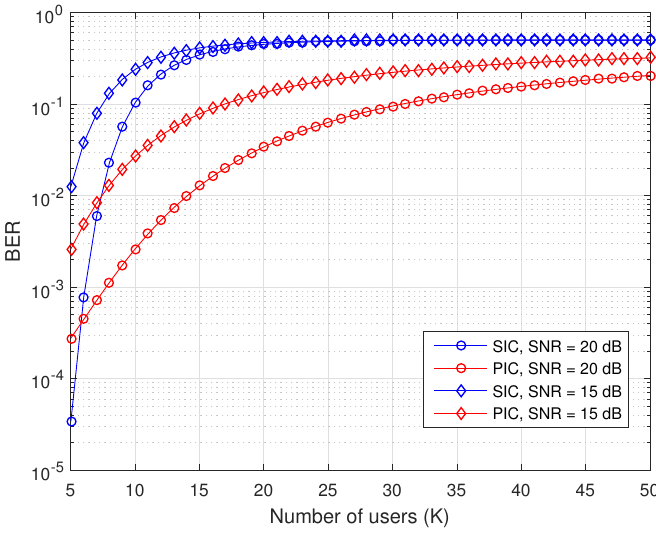
Figure 4. Bit error rate (BER) versus the number of users ( K ) for PIC and